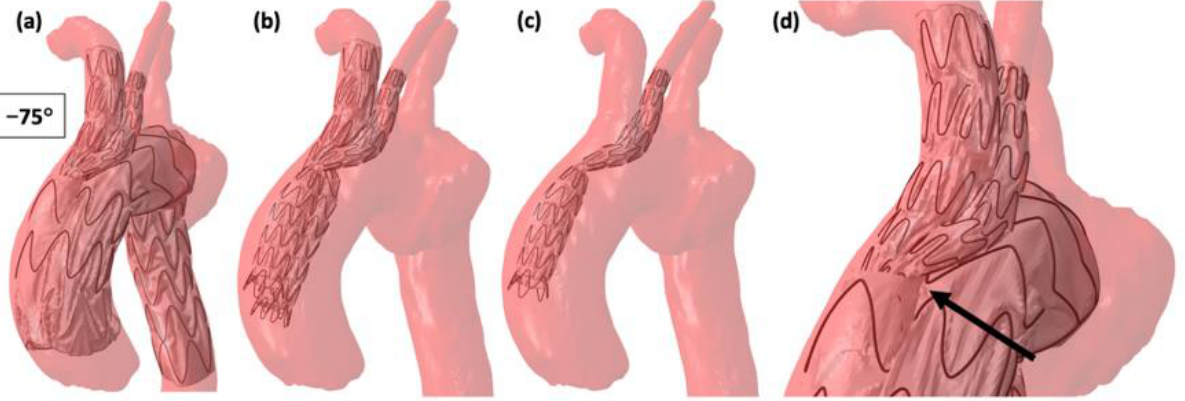
Figure 5. ( a ) Simulation result of deployment with − 75 ◦ rotation. ( b ) Picture of simulation result without the main stent-graft to facilitate visualization. ( c ) Picture showing only the bridging stent corresponding to the left carotid artery. ( d ) Simulation result: the arrow indicates the incongruence.